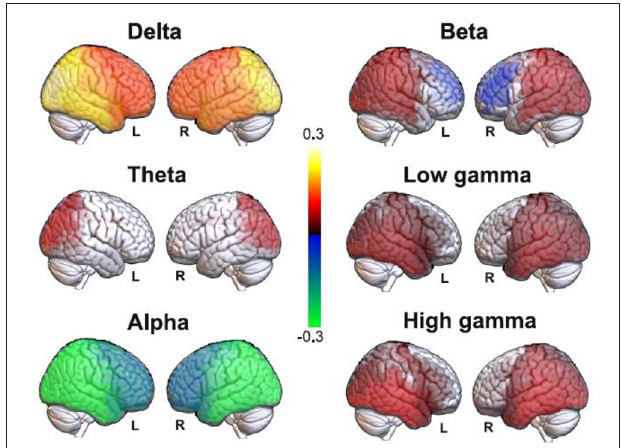
FIGURE 1 | Significant differences in band-specific source EEG power between the eyes closed baseline and the DMT condition. Red-yellow and blue-green color scales indicate increased and decreased spectral power under DMT compared to the baseline,